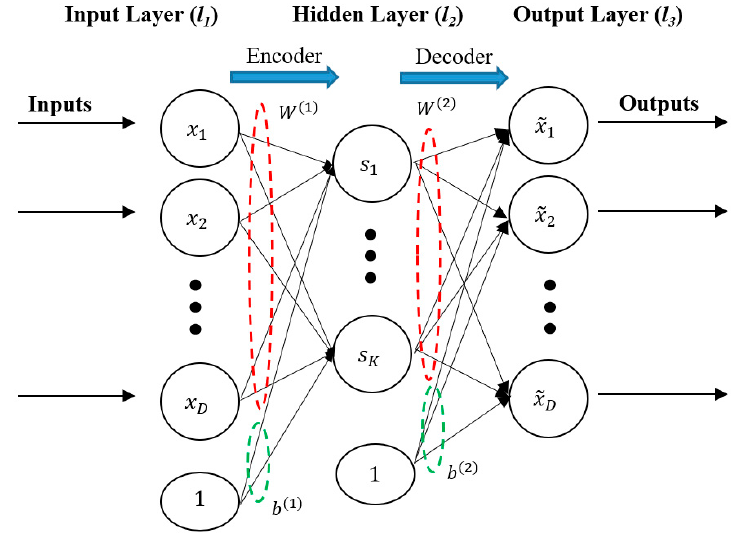
Figure 2. Sparse autoencoder structure.